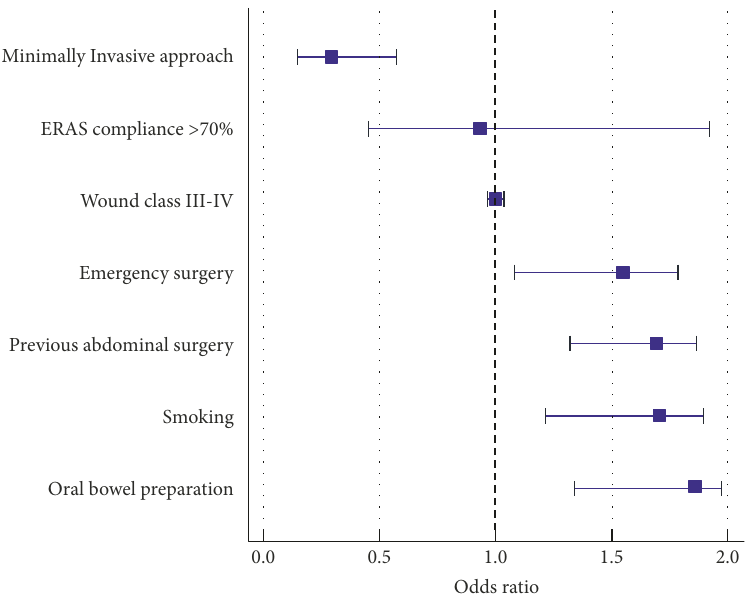
Figure 2: Independent risk factors for SSI. Odds ratio for outcome SSI, 95% con fi dence